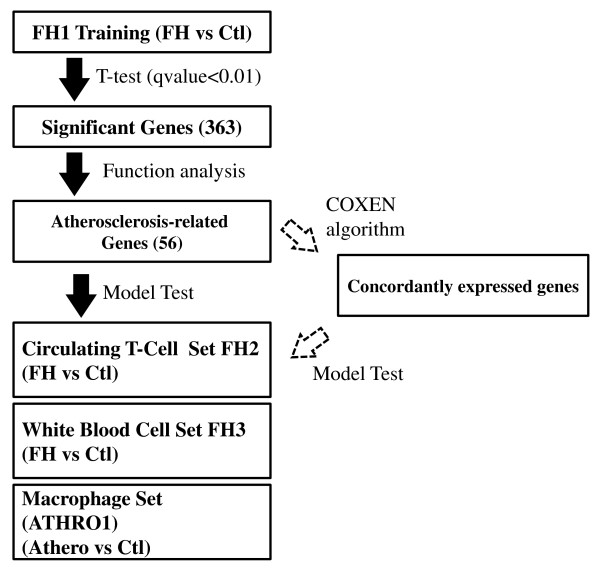
Schematic diagram of the atherosclerosis prediction model construction and validation processes. Our prediction model was developed by four distinct steps - 1) the identification of significant genes by t-test analysis of the training set FH1, 2) selected biomarkers known to be directly related to atherosclerosis performed by Ingenuity Pathway Analysis, 3) (optional) selection of COXEN biomarkers among the atherosclerosis-related gene biomarkers obtained from the third step which led to the 48, 6, and 26 biomarkers for test set 1 (circulating T-cell), test set 2 (white blood cell) and test set 3 (macrophage), 4) the multivariate prediction model construction based on universal or COXEN predictors.